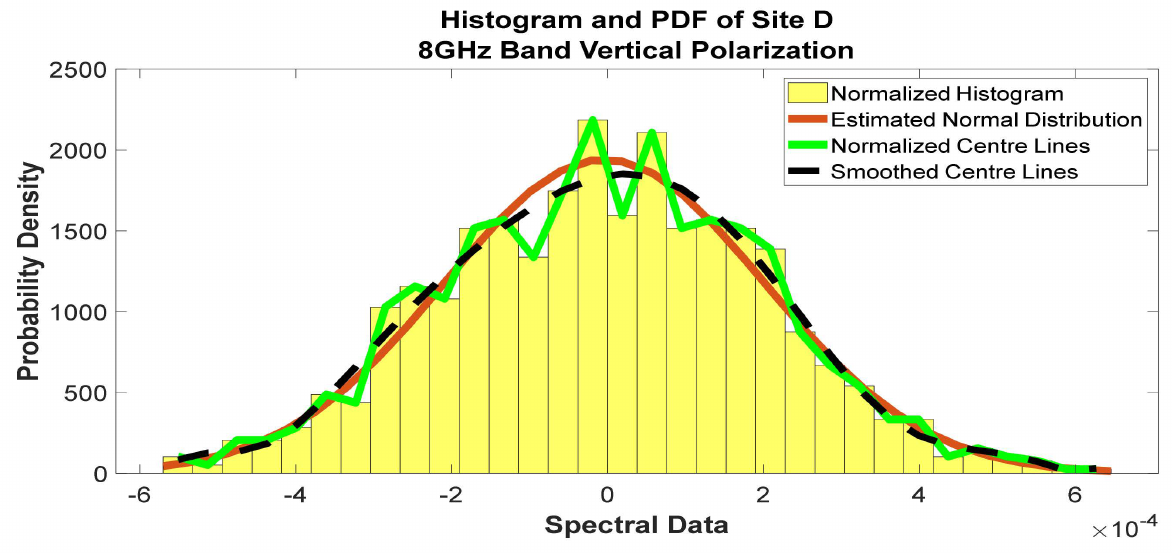
Figure 34. Histogram and PDF of the frequency scan for site D at 8 GHz vertical